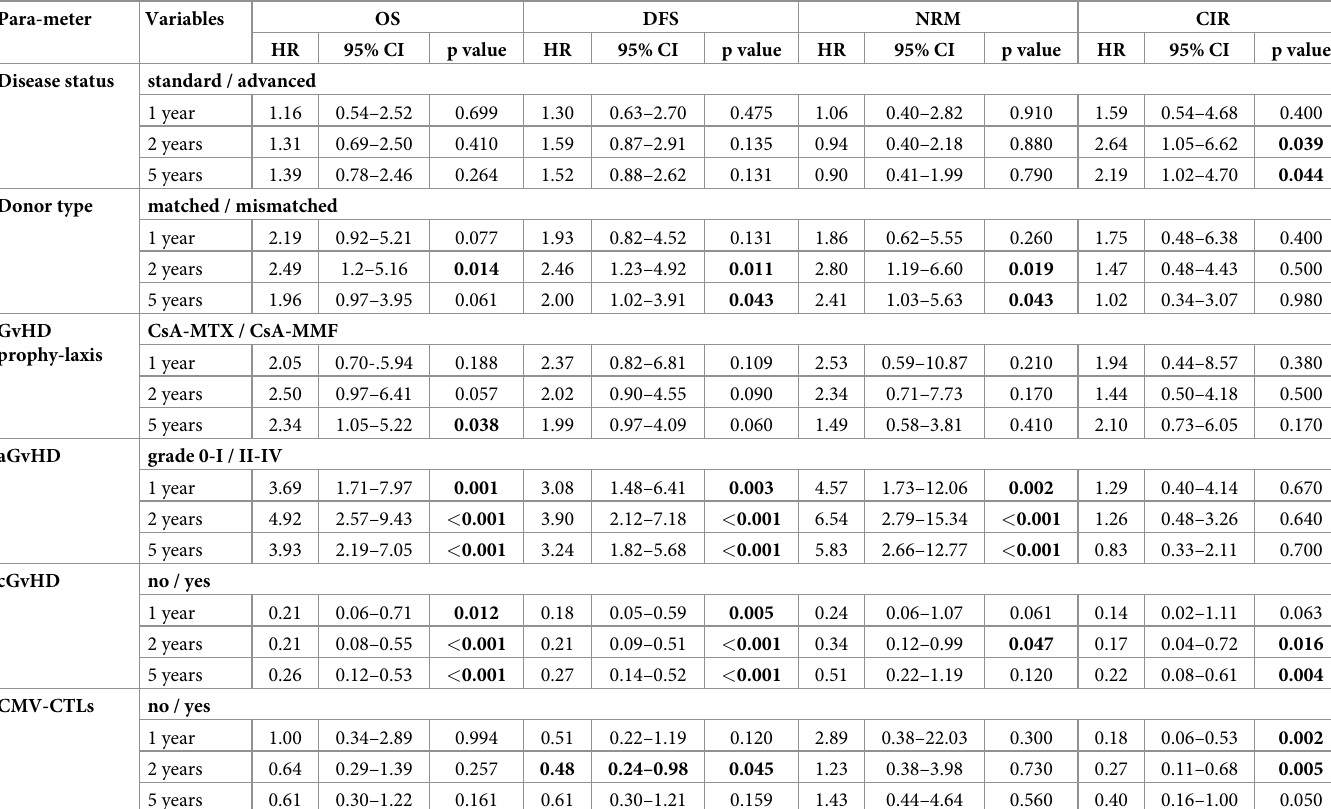
Table 3. Univariate analysis of the parameters influencing the outcome after allo-SCT. Para-meter